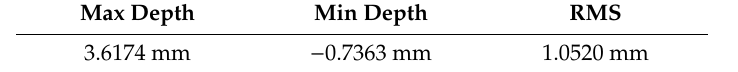
Table 9. The analysis result of the practical damaged rail.